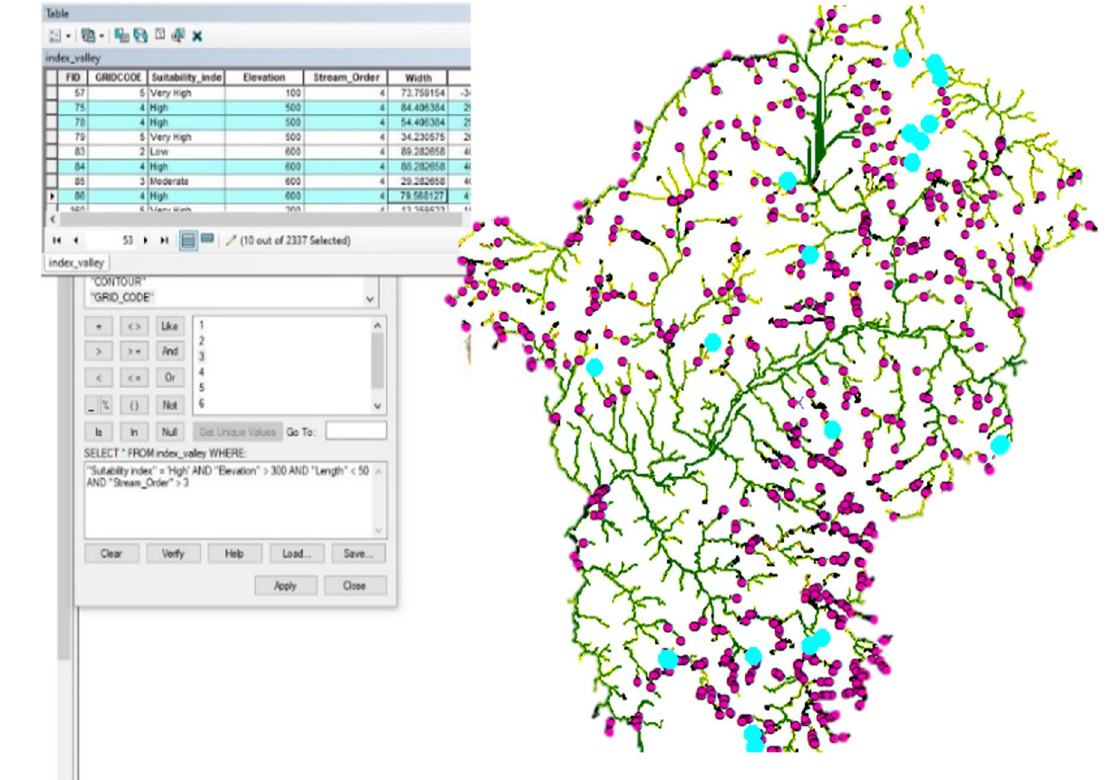
Fig. 9 Query operation to search and display valley